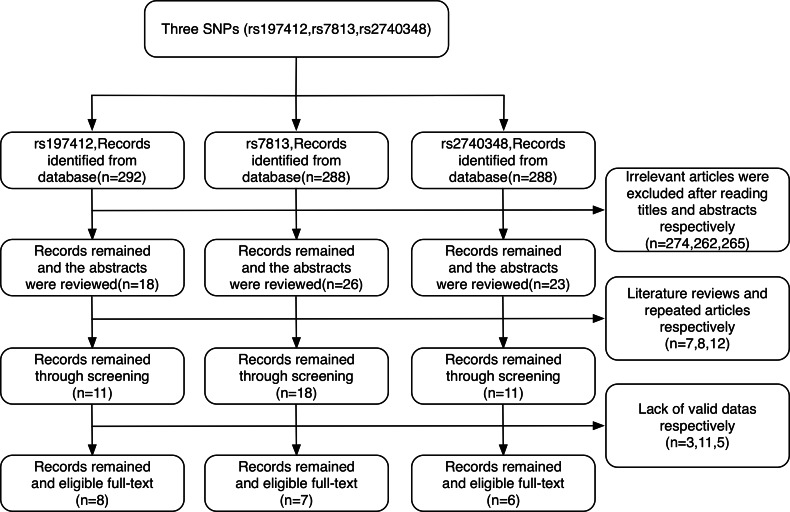
Flowchart for the identification of studies included in the meta-analysis.